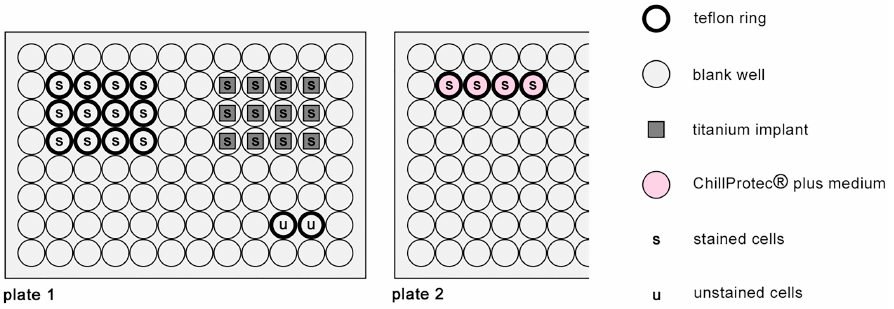
Figure 4. Experimental set-up for vitality and proliferation assays on titanium scaffolds.